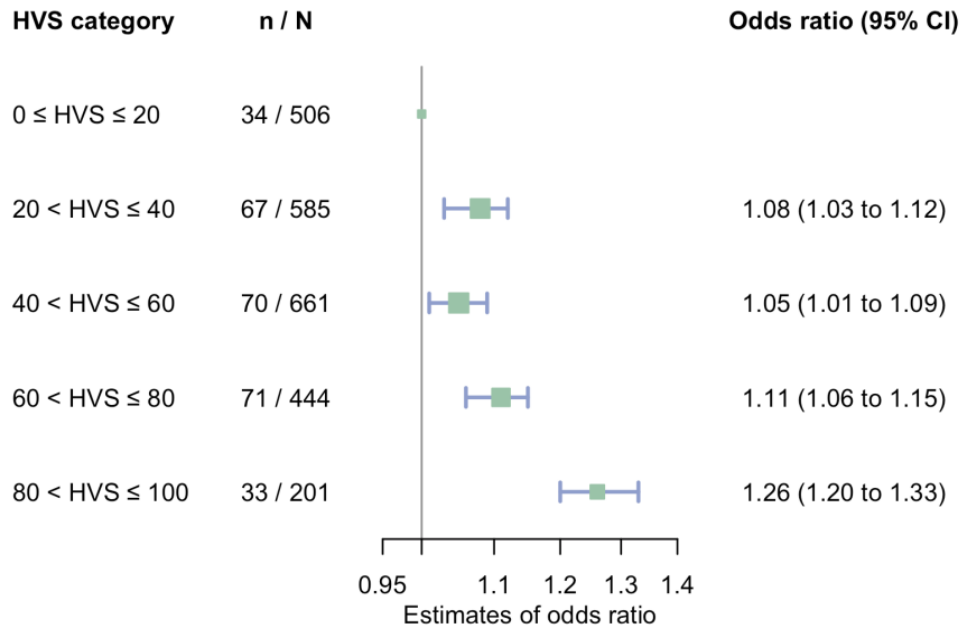
Figure 2. Odds ratio of HVS categories for experiencing a rapid eGFR annual decline. Abbreviations: HVS, glycated haemoglobin A1c variability score; eGFR, estimated glomerular filtration rate; CI, confidence interval. A rapid eGFR annual decline is defined as eGFR annual decline at 5 mL/min/1.73 m 2 /year or more on average from baseline to end of follow-up. Compared with people with HVS ≤ 20% whose eGFR declined by 0.33 mL/min/1.73 m 2 per year on average, the eGFR declined by an extra 0.93 mL/min/1.73 m 2 (95% CI, 0.46 to 1.39; >MID) per year on average in people with the HVS between 60% and 80% and an extra 1.83 mL/min/1.73 m 2 (95% CI, 1.17 to 2.50; >MID) per year on average in those with an HVS above 80% (Figure 3). Subgroup analyses indicated that ever use or never use of insulin could modify the difference between people with HVS of 60% to 80% and those with HVS ≤ 20% in the mean eGFR slope but not between those in other HVS categories and HVS ≤ 20% (Figure S6). All sensitivity analyses showed the robustness of the findings (Figures S7 – S11). Figure 3. Difference across HVS categories in the mean eGFR slope starting from baseline to end of follow-up. Abbreviations: HVS, glycated haemoglobin A1c variability score; eGFR, estimated glo- merular filtration rate; CI, confidence interval.